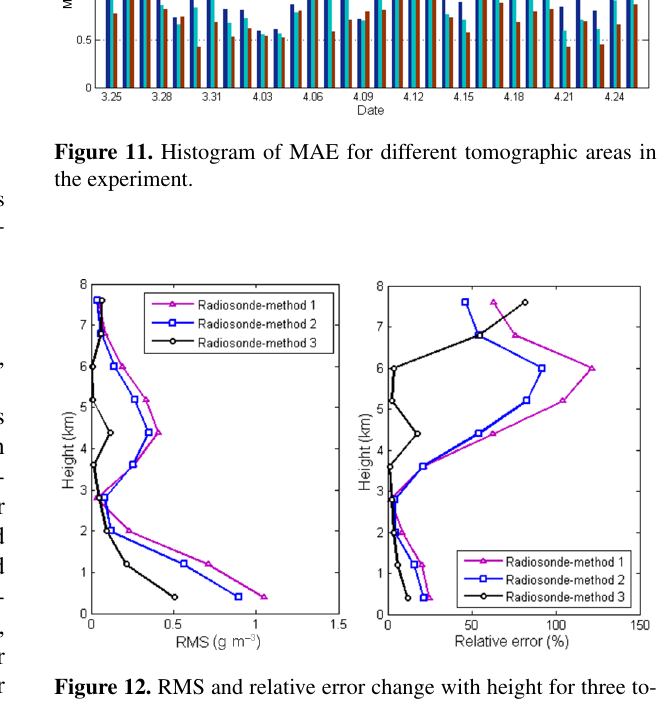
Figure 12. RMS and relative error change with height for three to- mographic methods from 25 March to 25 April